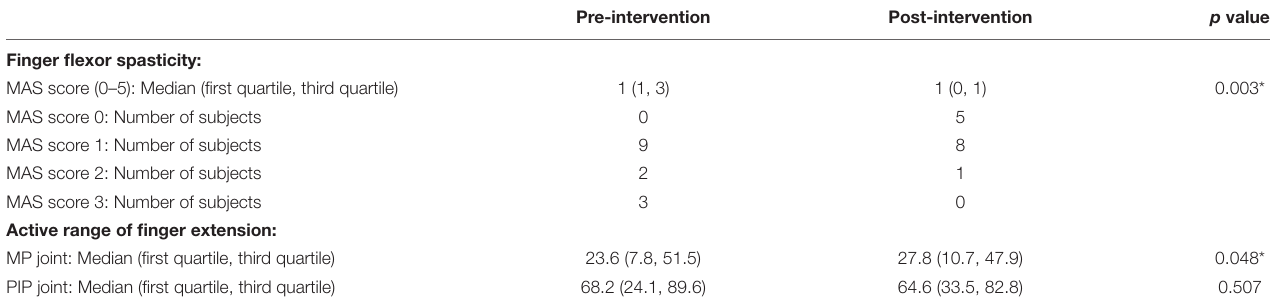
TABLE 2 | Results of finger spasticity and active range of finger extension. Pre-intervention Post-intervention p value